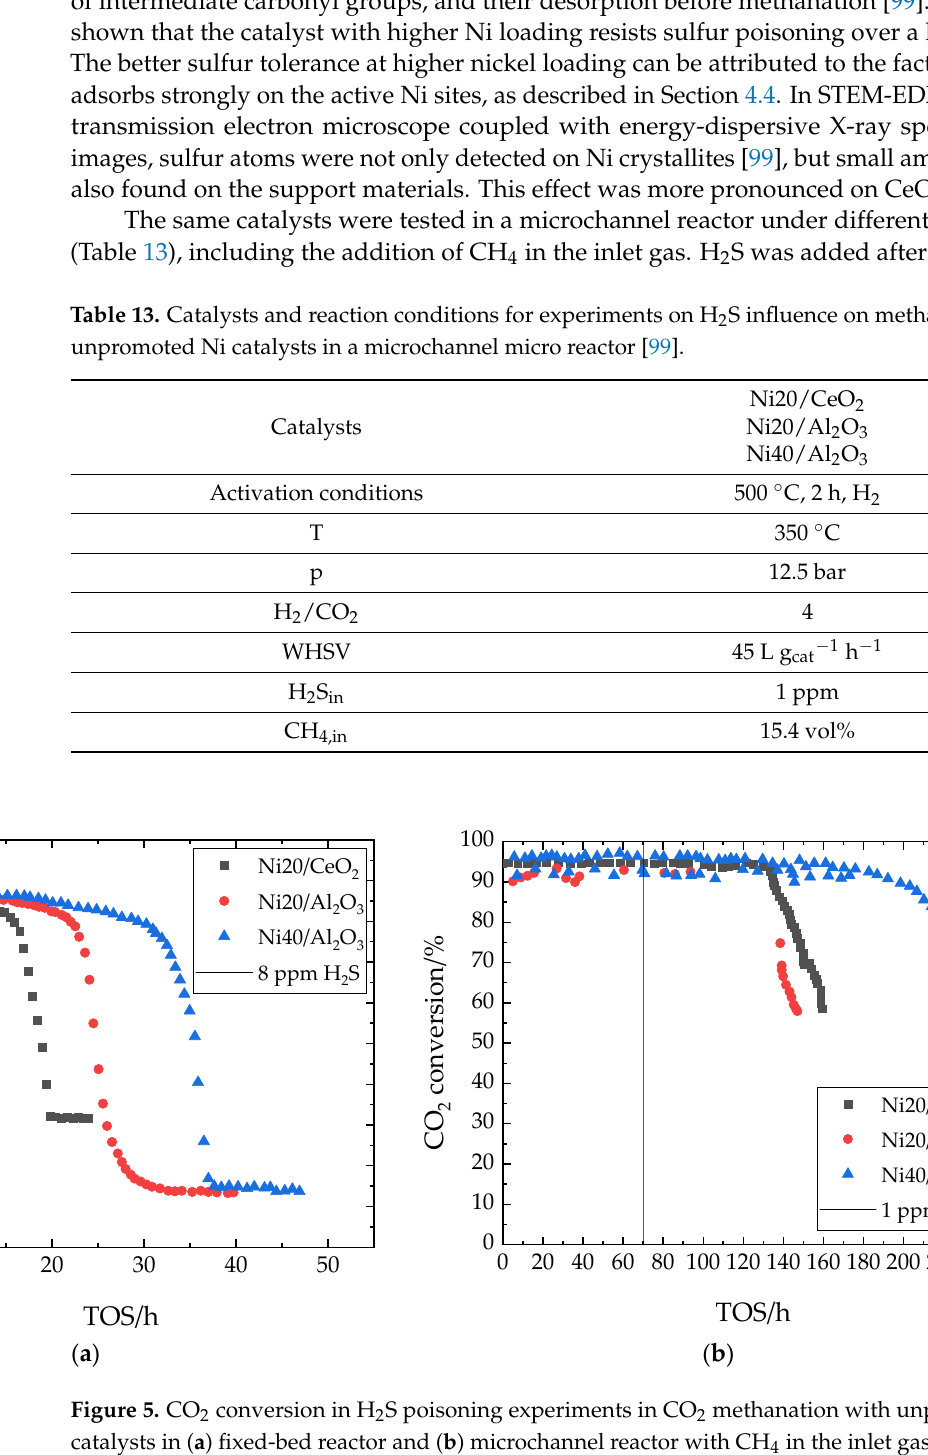
Table 13. Catalysts and reaction conditions for experiments on H 2 S influence on methanation with unpromoted Ni catalysts in a microchannel micro reactor [99]. Catalysts